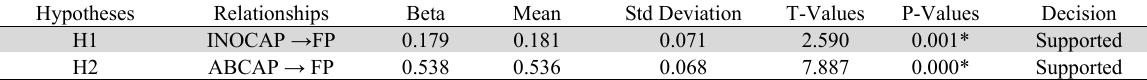
Results of the Structural Model Path Coefficient Direct Hypothesis Testing Hypotheses Relationships Beta